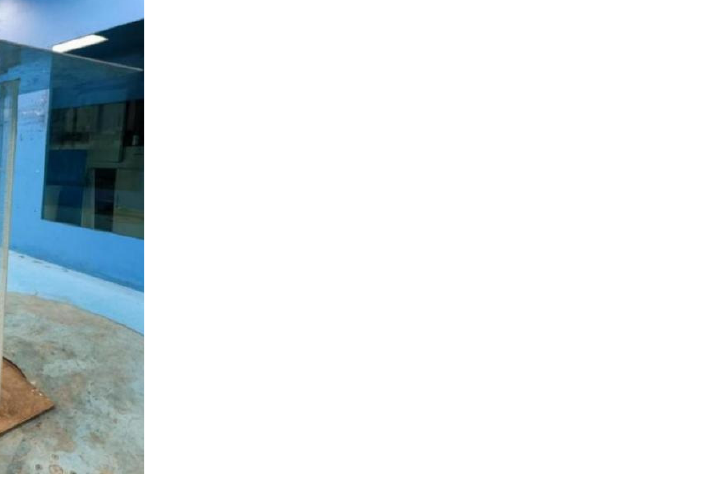
Figure 11. Segment model of the girder of the sea ‐ crossing bridge in wind tunnel laboratory.